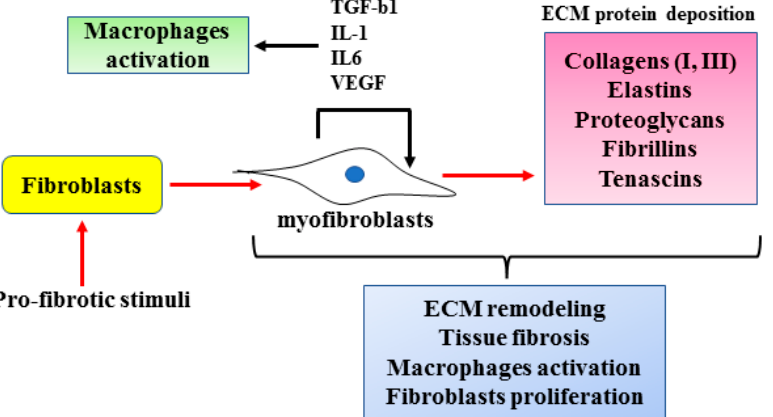
Figure 2. Cellular mechanisms regulating fibrosis. Under pro-fibrotic stimuli, fibroblasts, among the several cell types, as explained in the text, differentiate into myofibroblasts that produce extracellular matrix (ECM) components leading to tissue fibrosis. Myofibroblasts cross-talk with macrophages and this interplay contributes to tissue fibrosis.